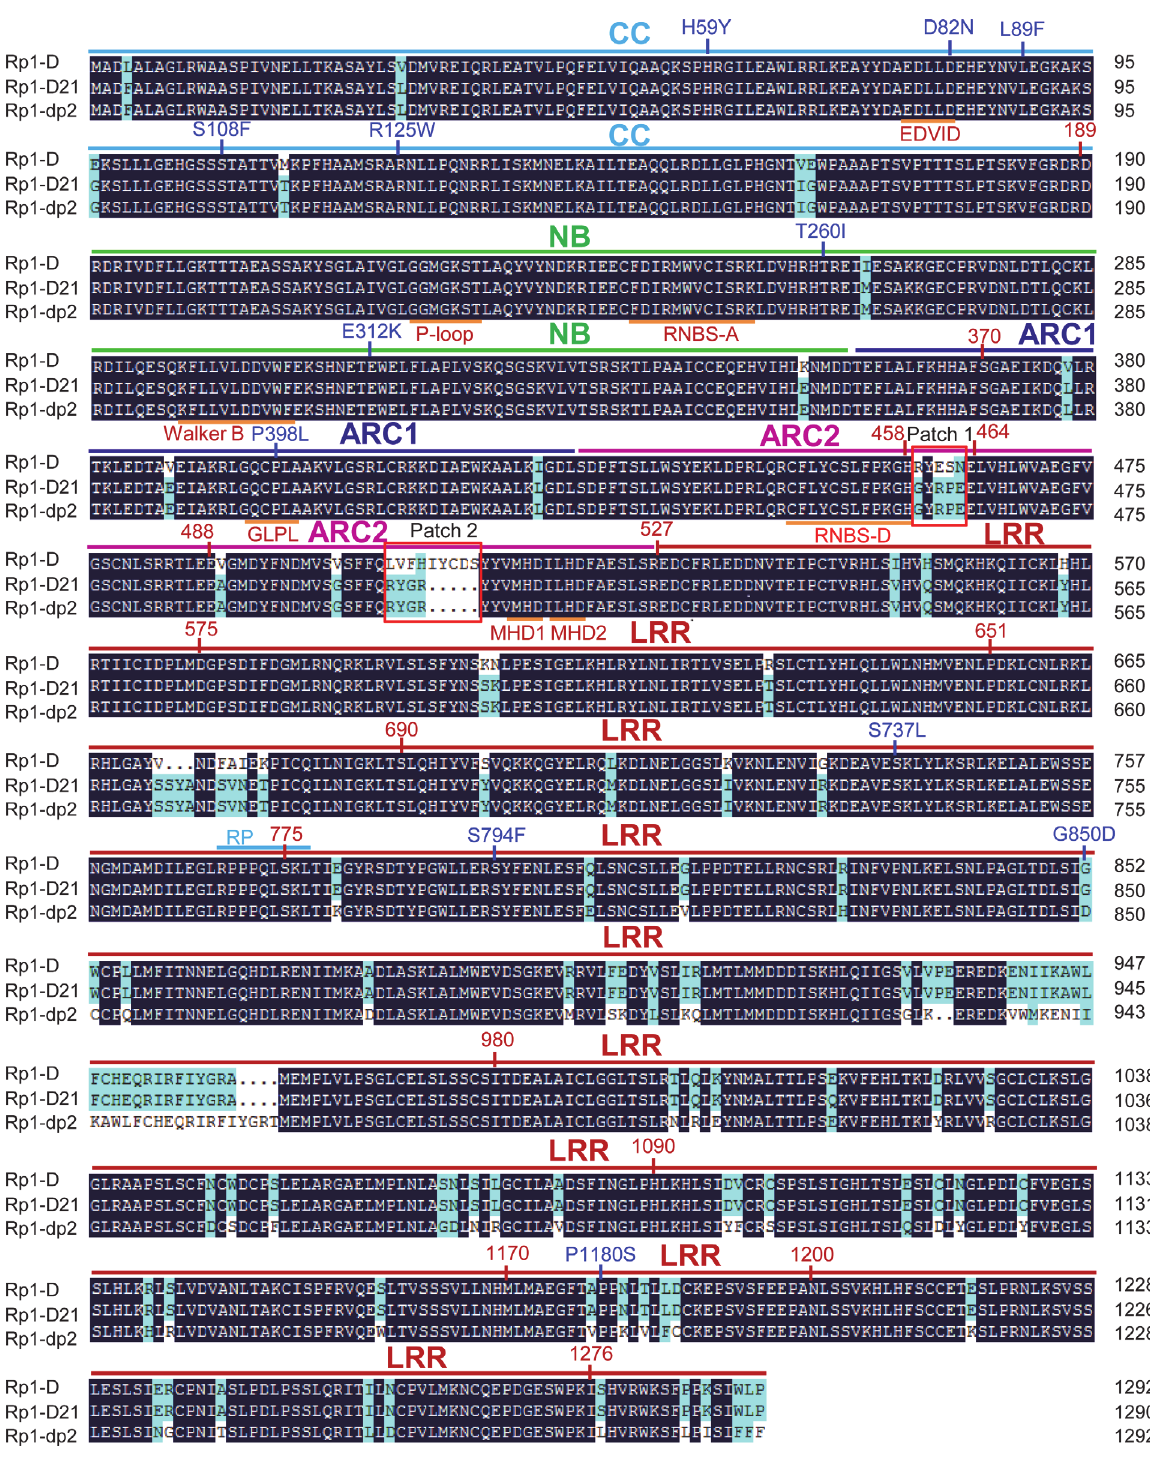
Fig 1. Sequence alignment of Rp1-D, Rp1-dp2 and Rp1-D21. The CC (coiled-coil), NB-ARC (nucleotide binding), ARC1 (APAF1, R gene products and CED-4), ARC2 and LRR (leucine-rich-repeat) domains were indicated by bars with cyan, green, dark blue, pink and red colors, respectively. The conserved motifs (EDVID, P-loop, GLPL, RNBS-D, MHD1 and MHD2) were indicated by orange bars and labeled below the sequences. The recombination point of Rp1-D21 was labeled by cyan bar. Patches 1 and 2 are the major difference regions between Rp1-D and Rp1-dp2 in the ARC2 domain. The positions of the mutations in the intragenic Rp1-D21 suppressor from maize were labeled by blue color. The landmark positions of recombination points in the constructs listed in Fig. 6 were labeled by numbers with red color. The black and light blue shaded regions represent 100% and above 50% similarity of the amino acids,